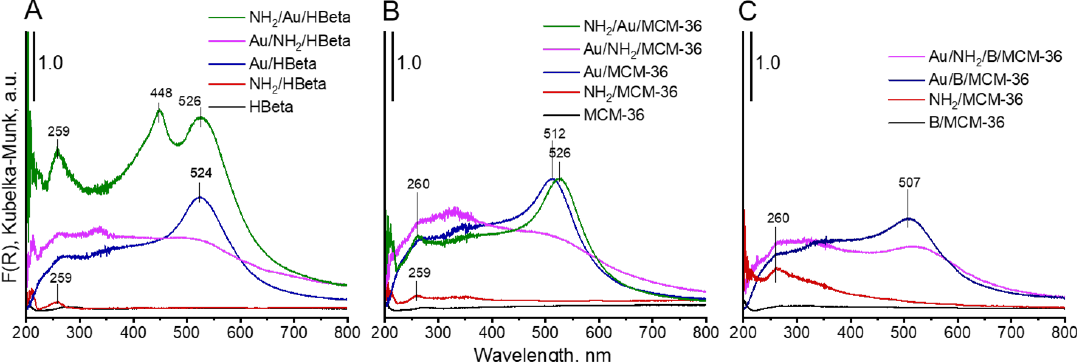
Figure 5. DR-UV-vis spectra of prepared materials.